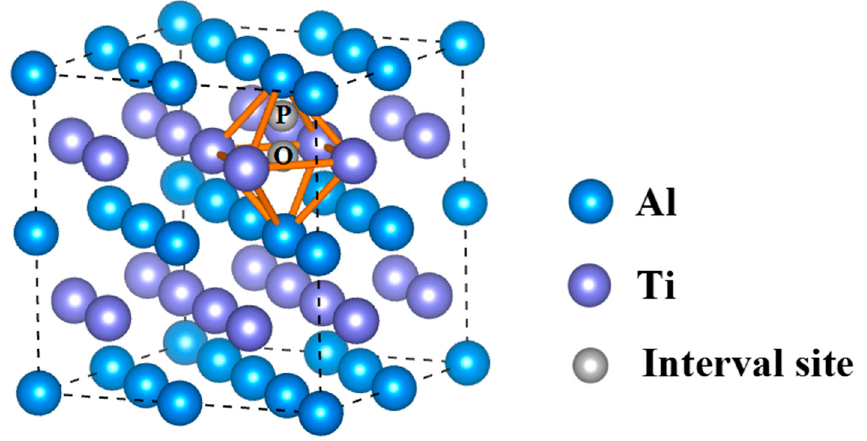
Figure 1. A 2 × 2 × 2 supercell of γ -TiAl matrix marked with the pentahedron (P) site and octahedral (O) site represented as gray spheres, where Ti atoms are represented as purple spheres and Al atoms are represented as blue spheres.